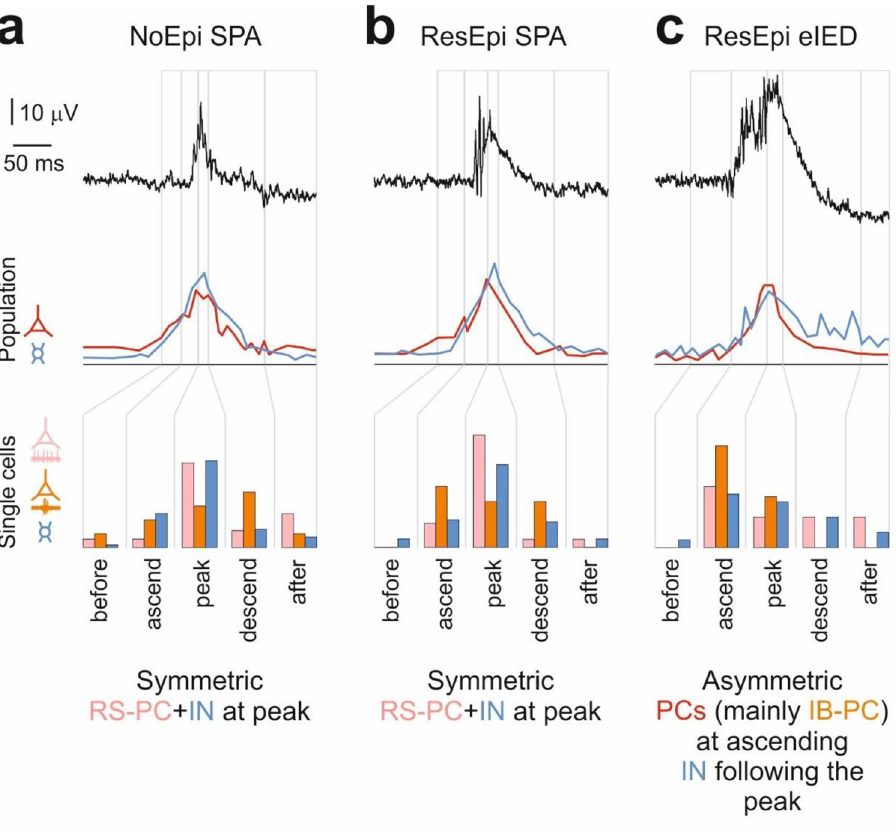
Figure 6. Cellular mechanisms of physiological SPAs and pathological eIEDs. This figure summarises the excitatory (reds) and inhibitory (blue) cellular processes during physiological ( a , b ) and pathological ( c ) synchronies. Upper traces show a broad-band recorded example for NoEpi SPA ( a ), ResEpi SPA ( b ) and eIED ( c ). Note that the after phases are cropped in the figure. Grey lines demarcate the five phases of synchronous events. Line graphs show the summed firing of the PC (red) and IN (blue) populations. Bar graphs show the elevated firing of regular spiking (RS, light pink) and intrinsically bursting (IB, orange) PCs as well as INs (blue) during the five phases of synchronous events. During ResEpi eIEDs INs show a prolonged increase in firing after the LFPg peak. The activity of RS-PCs and INs is highly connected to the peak phase of SPAs (both NoEpi and ResEpi). IB-PCs seem to fire mostly during the descending phases of NoEpi SPAs, ubiquitously during ResEpi SPAs and mostly during the ascending phase of ResEpi eIEDs. A largely symmetric build up and decline